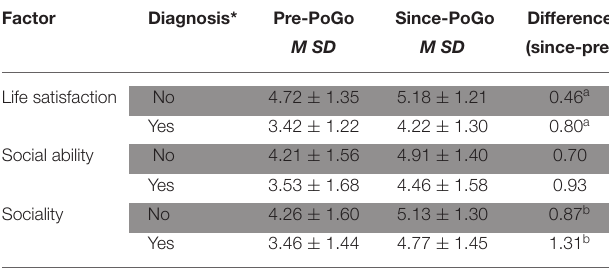
TABLE 3 | Means and SDs for the three factors by time period and diagnosis